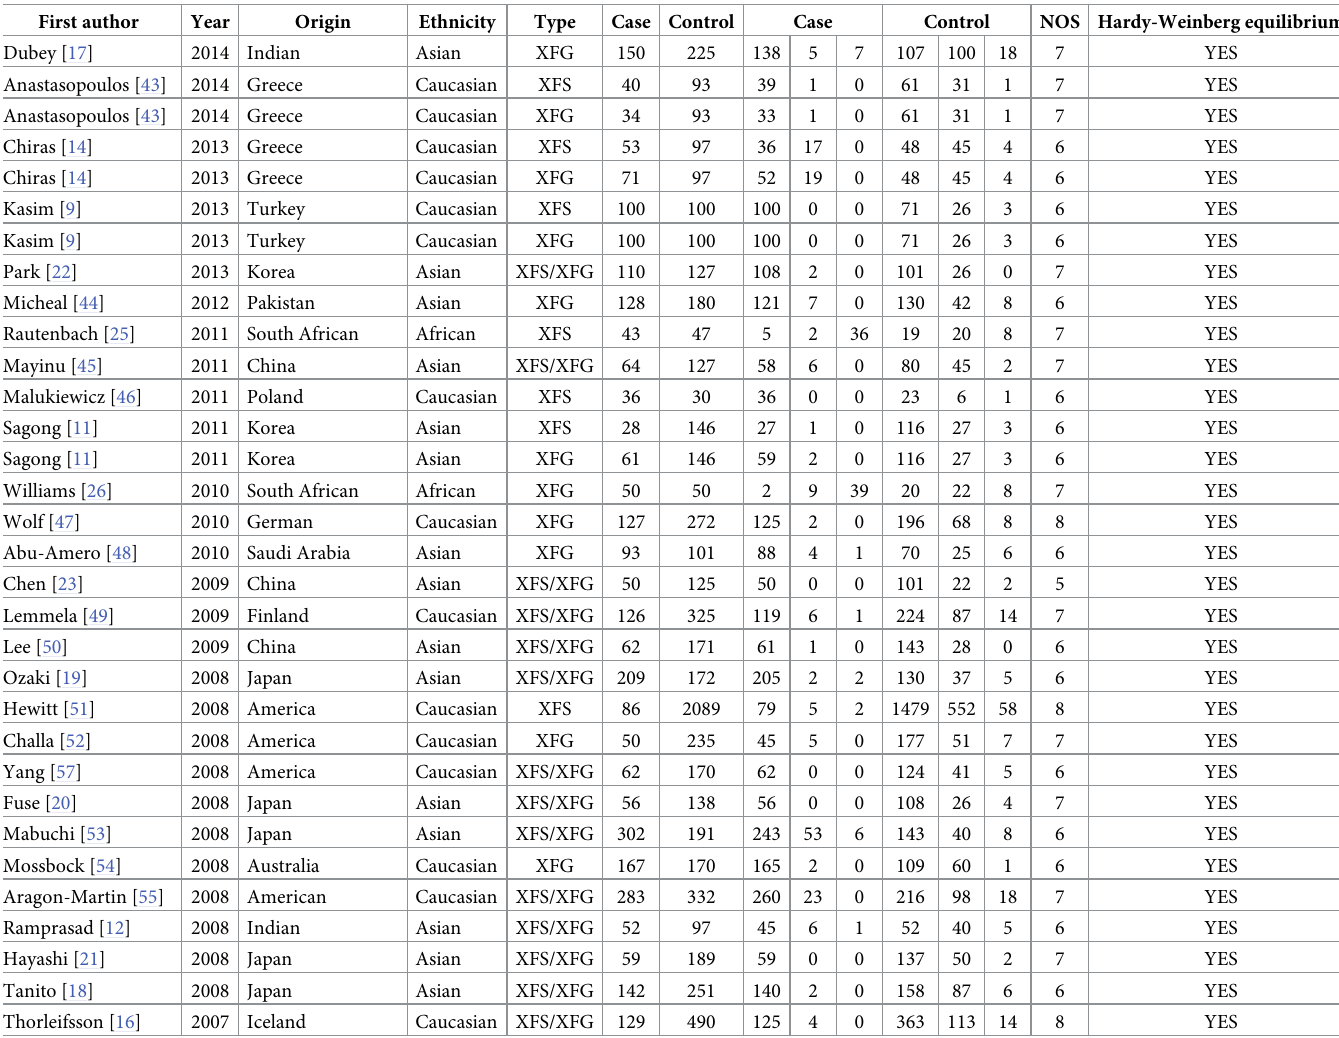
between the LOXL1 gene rs2165241 polymorphism and XFS/XFG risk in Asians (T vs. C, OR: 0.65, 95%CI: 0.36–1.17, p :0.15) (Fig 5, Table 2). A summary of the results from other compara- tive genetic models is also shown in Table 2. rs3825942 LOXL1 gene polymorphism. For the LOXL1 gene polymorphism, rs3825942, 38 articles were included in our meta-analysis. Overall analyses revealed a positive LOXL1 rs3825942 (G vs. A, OR: 5.33, 95%CI: 3.49–8.16, p < 0.001) association with XFS/XFG suscepti- bility (Table 2). In the subgroup analysis by disease type, the LOXL1 rs3825942 gene polymor- phism revealed a significant association with XFS (G vs. A, OR: 4.16, 95%CI: 1.86–9.30, p < 0.001) and XFG (G vs. A, OR: 4.72, 95%CI: 2.10–10.60, P < 0.001) (Fig 6, Table 2) susceptibil- ity in a genetic model, G vs. A. In subgroup analysis by ethnicity, increased risks were identi- fied among Caucasians (G vs. A, OR: 6.48, 95%CI: 3.67–11.44, P < 0.001) and Asians (G vs. A, OR: 5.89, 95%CI: 3.79–9.16, p < 0.001) (Fig 7, Table 2), suggesting that variant G allele carriers are at higher risk of XFS/XFG relative to A allele carriers. In contrast, the G allele